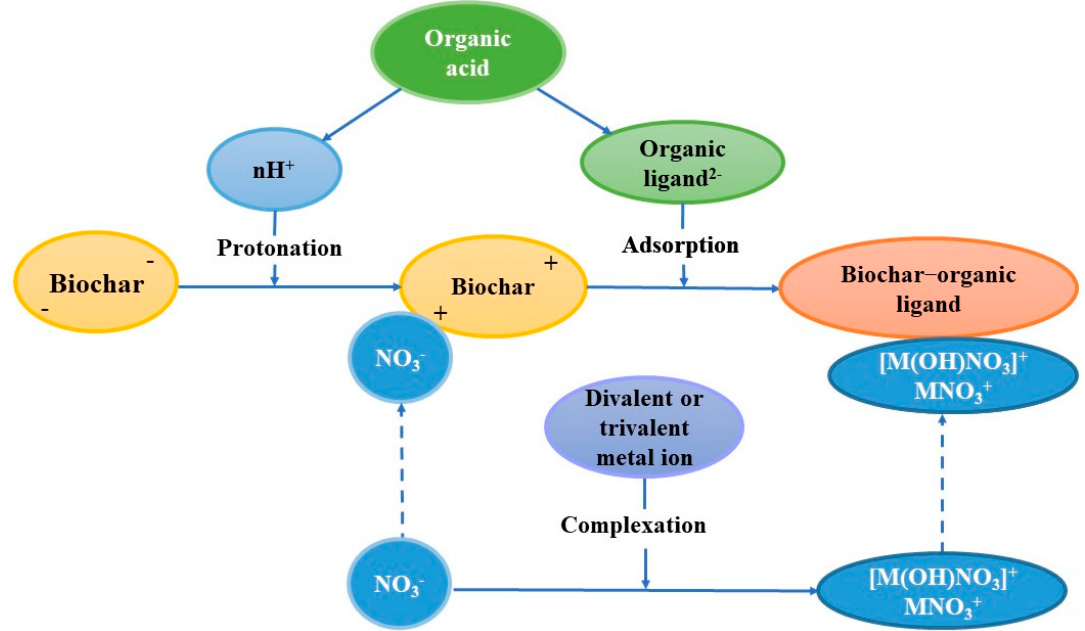
Figure 3. A schematic flow chart illustrating the chemical mechanisms responsible for the nitrate retention by biochar in the presence of LMWOAs.